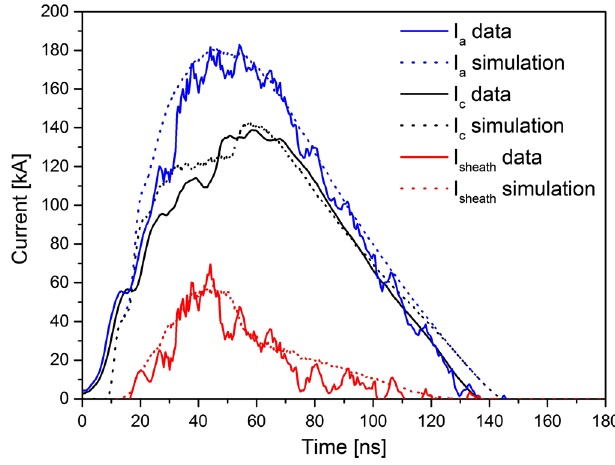
FIG. 5. Simulated and experimental anode, cathode and sheath currents at the end of the tenth cavity (location A on Fig. 3) for a 24.5 mm gap